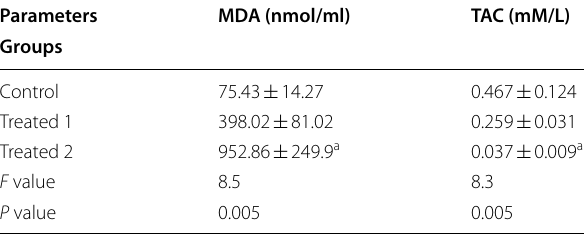
O NPs on ovarian oxidative status 3 4